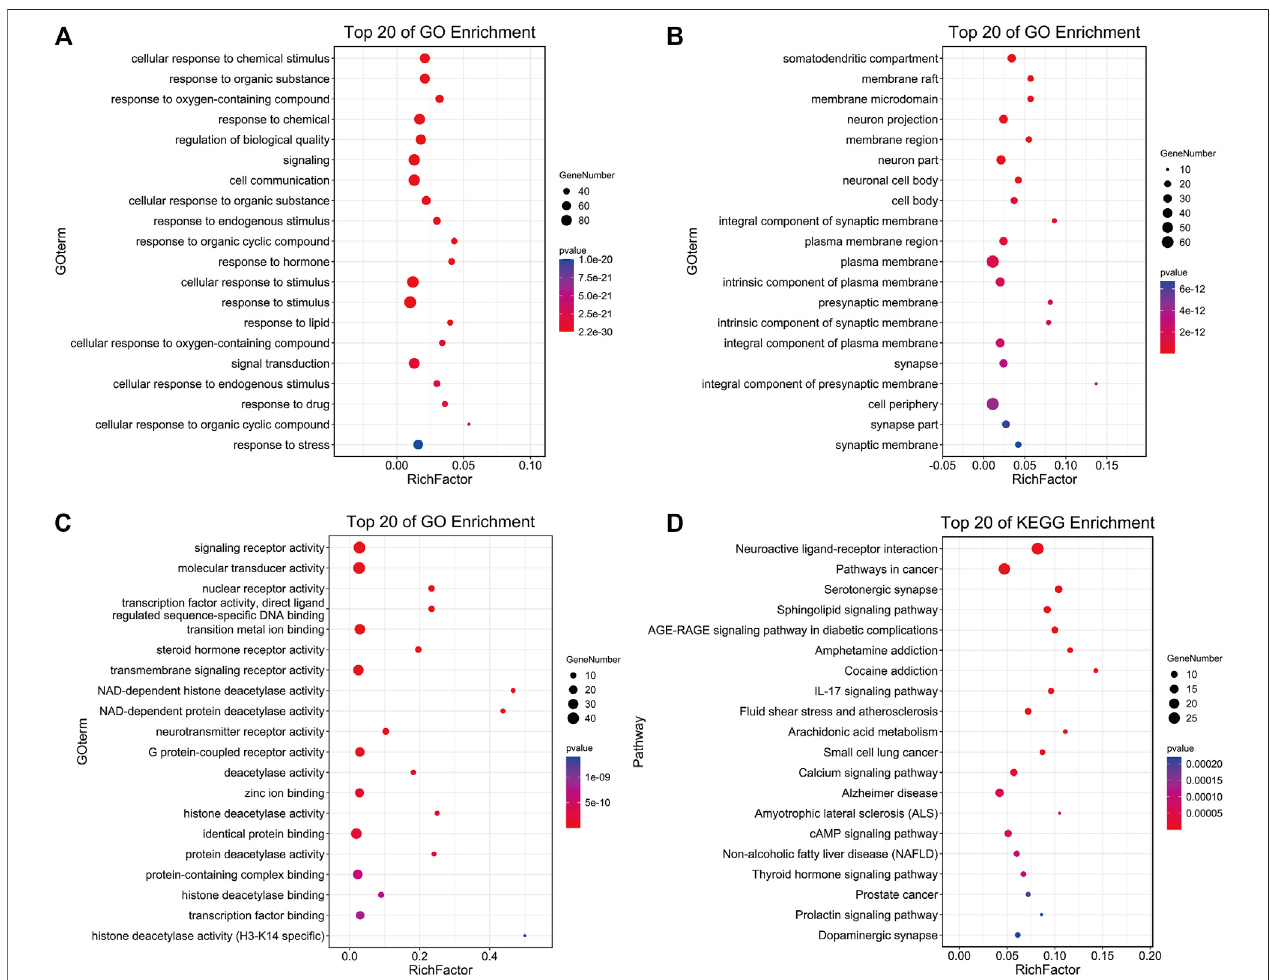
FIGURE 3 | The enrichment results of CC (A) , BP (B) , MF (C), and KEGG pathway (D) of Formula 9002A predicted targets.